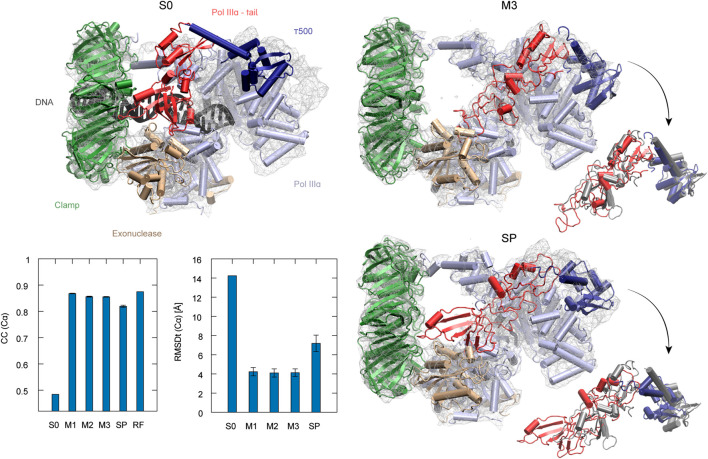
DNA polymerase fitting. S0: Initial structure with the target density map. Position of DNA is shown in black (not included in simulations). M3 and SP are the highest CC models obtained with the multi-scale and simple protocols, respectively. τ500 and tail of PolIIIα are additionally superimposed with the reference structure (RF) in dark gray in the insets. The average CC and RMSDt for 5 best models in each run are shown in the graphs with standard deviation marked as error bars.